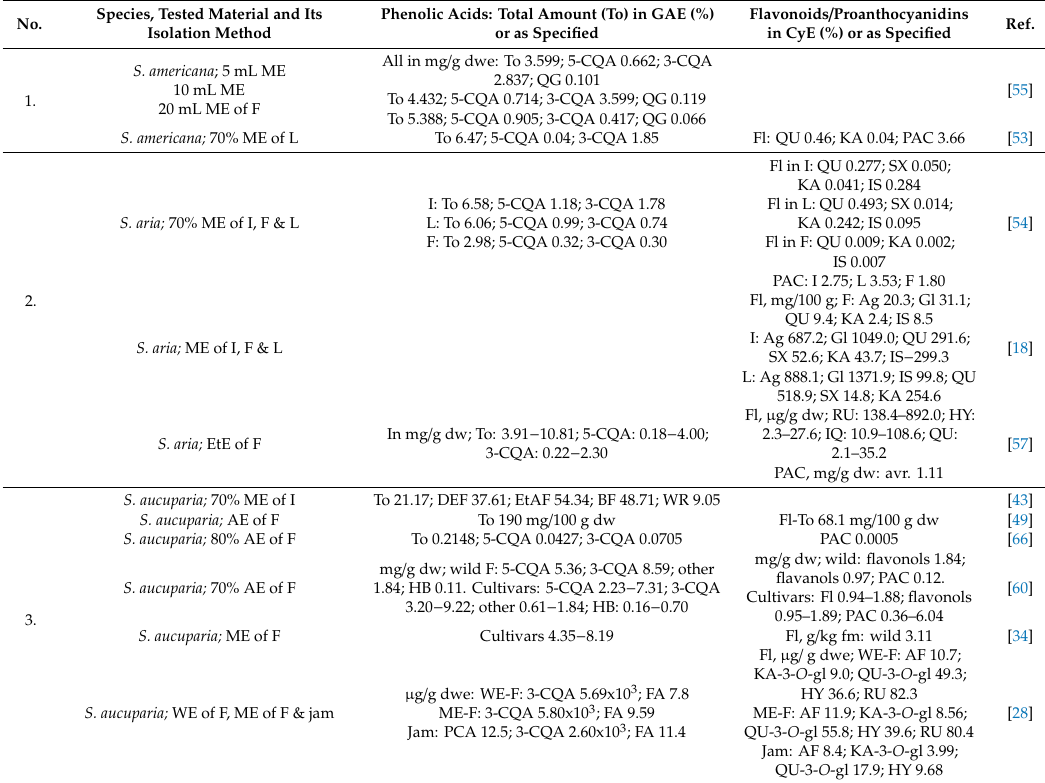
Figure 2. The structures of the main Sorbus flavonoids. Table 2. Bioactive compounds in selected Sorbus